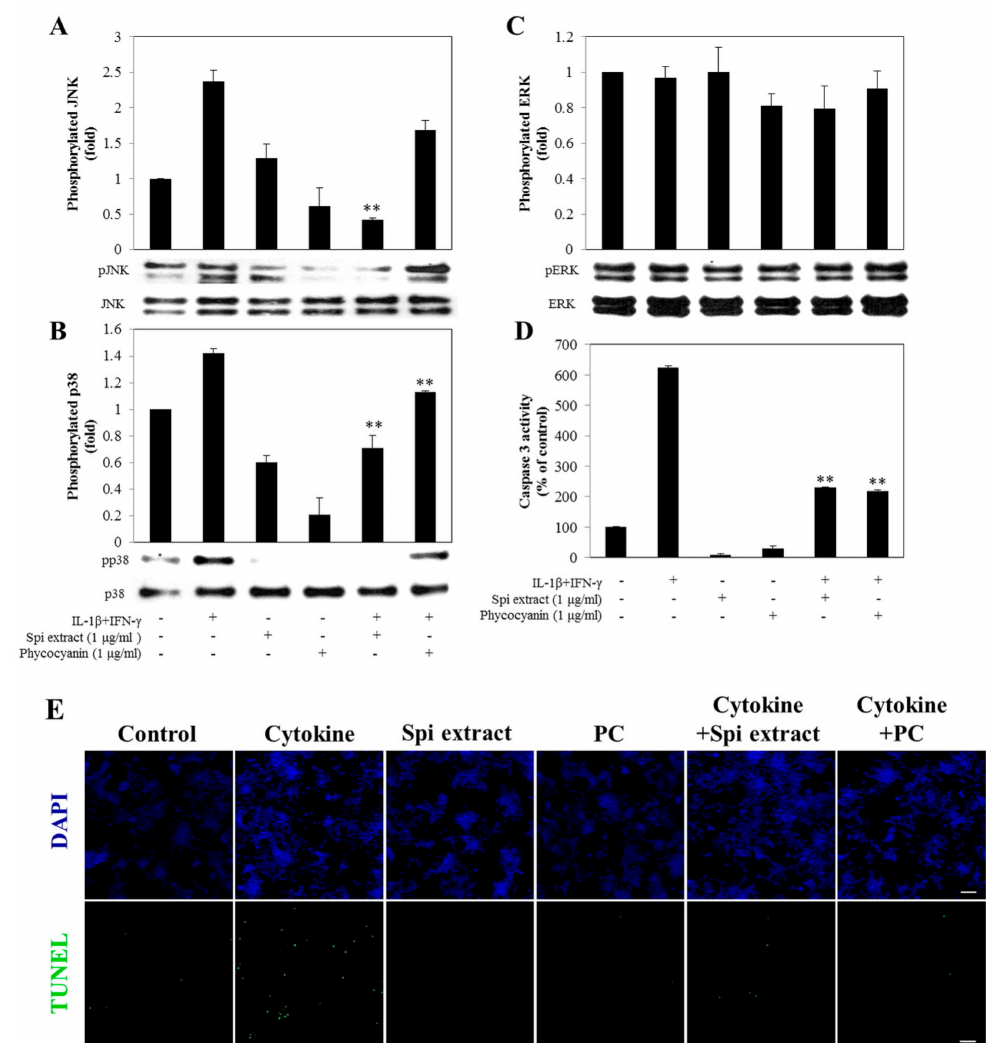
Figure 6. Spirulina extract attenuated RINm5F cells from cytokine-induced apoptosis. RINm5F cells were co-treated with Spirulina (Spi) extract or PC, and IL-1 β and IFN- γ for 30 min. ( A ) Western blot analysis of JNK; ( B ) p38 phosphorylations; ( C ) ERK phosphorylations and ( D ) Caspase-3 activity in RINm5F cells. The relative expression levels of proteins were determined using SYNGENE Gel Image software and the control band was given an arbitrary value of 1; ( E ) DNA fragmentation detected by the TUNEL assay (magnification, 200 × ). TUNEL-positive nuclei due to DNA fragmentation appear as green areas. Each value represents the mean ± SEM of three independent experiments. The two-sample t -test was used to compare the results between the control group and treatment group. ** p < 0.01, significant difference between the Cytokine-treated and the Cytokine + Spi extract or Cytokine + PC